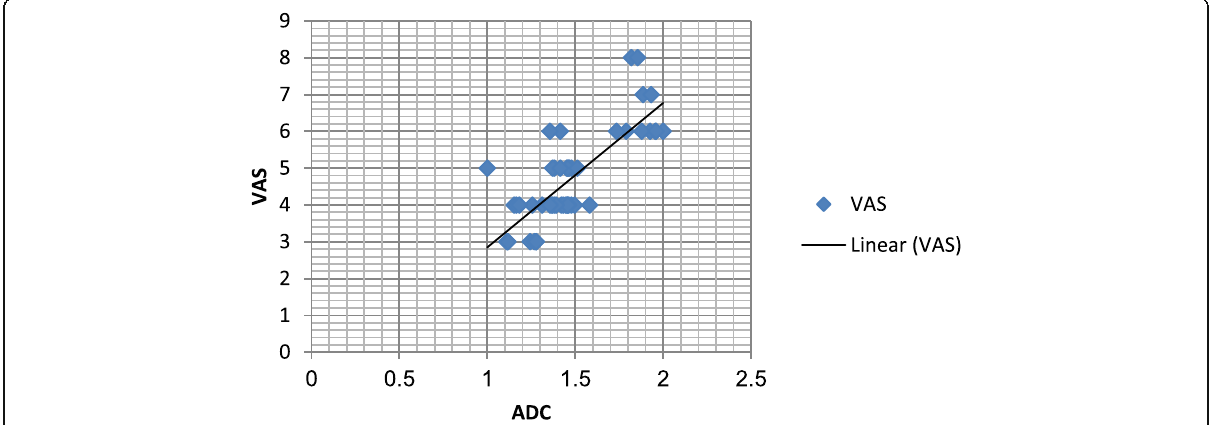
Fig. 5 Correlation between ADC and VAS scores for compressed